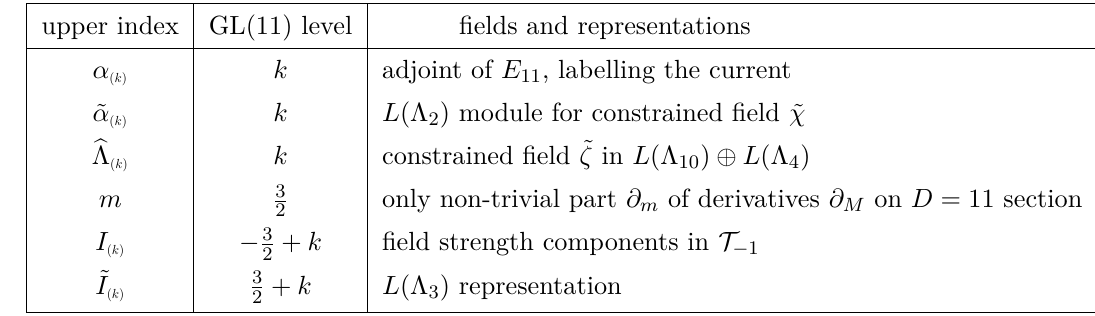
Table 3 . Index assignments for the indices of the various representations in GL(11) level decom- position. See also appendix C for details on the level